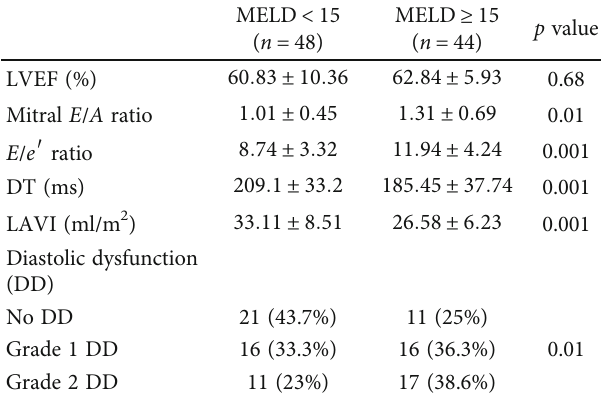
Table 3: Echocardiographic parameters in decompensated cirrhotic patients, classi fi ed as per MELD status.